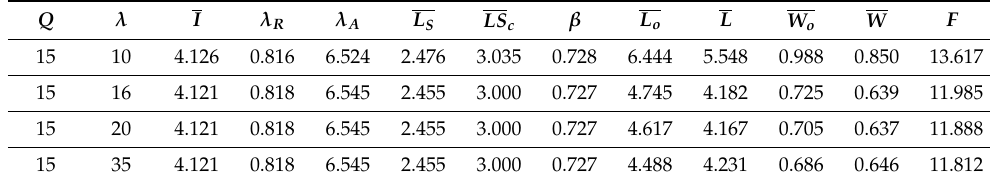
Table 6. The effect of µ on performance measures at Q = 15.